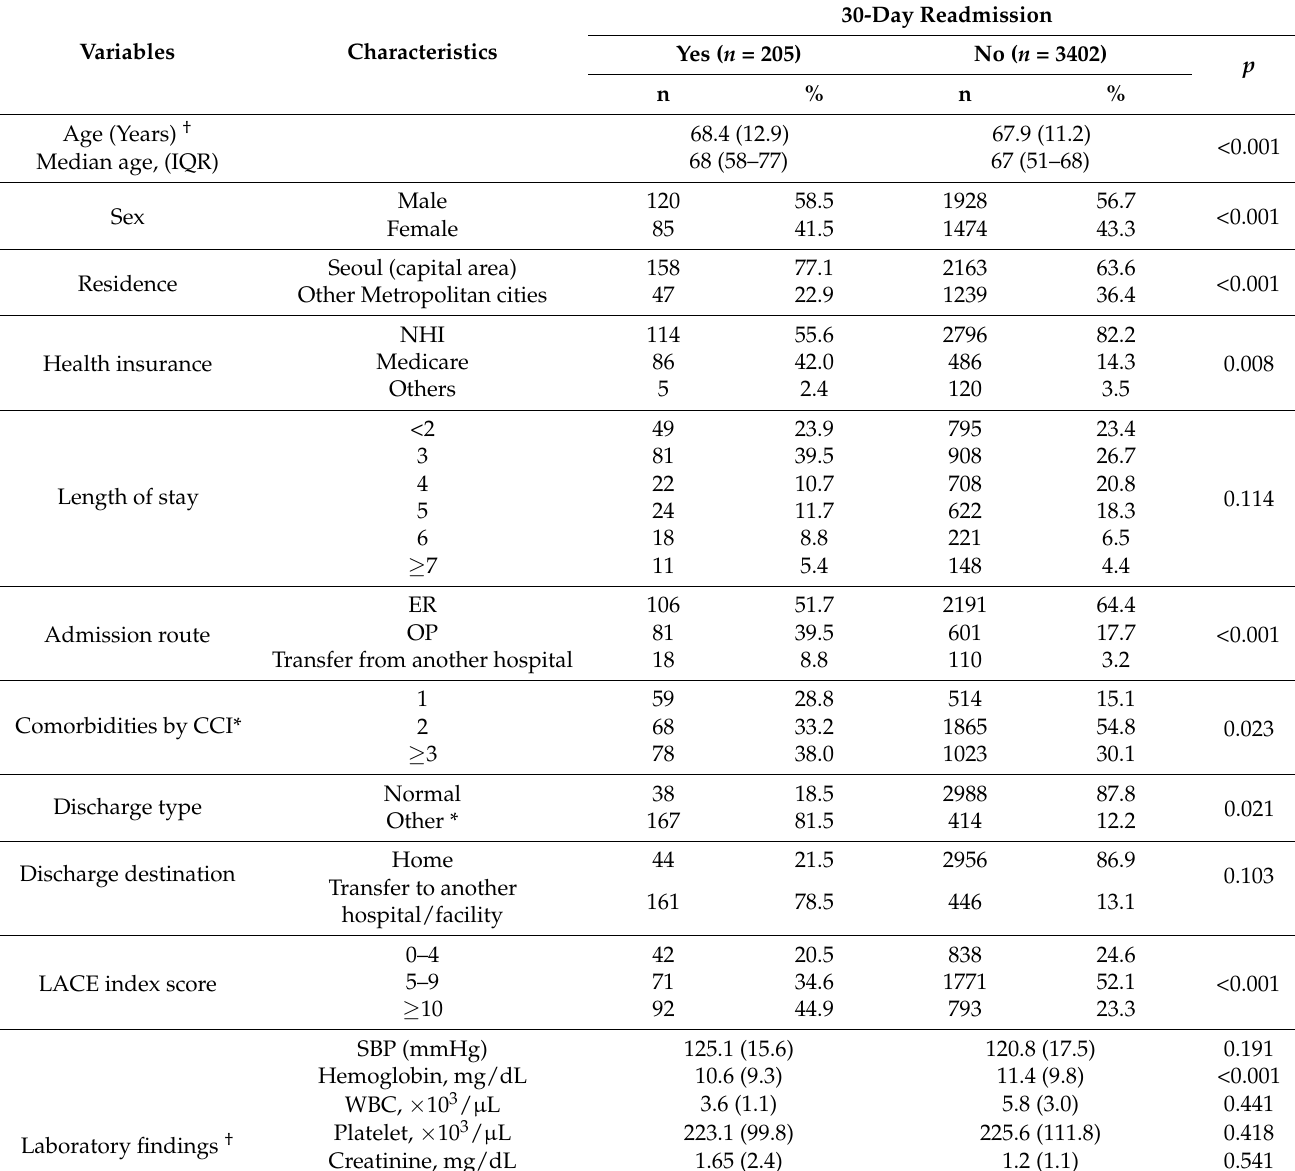
Table 1. Baseline Characteristics of 30-day Readmissions and Non-Readmissions in Patients Hospi- talized with